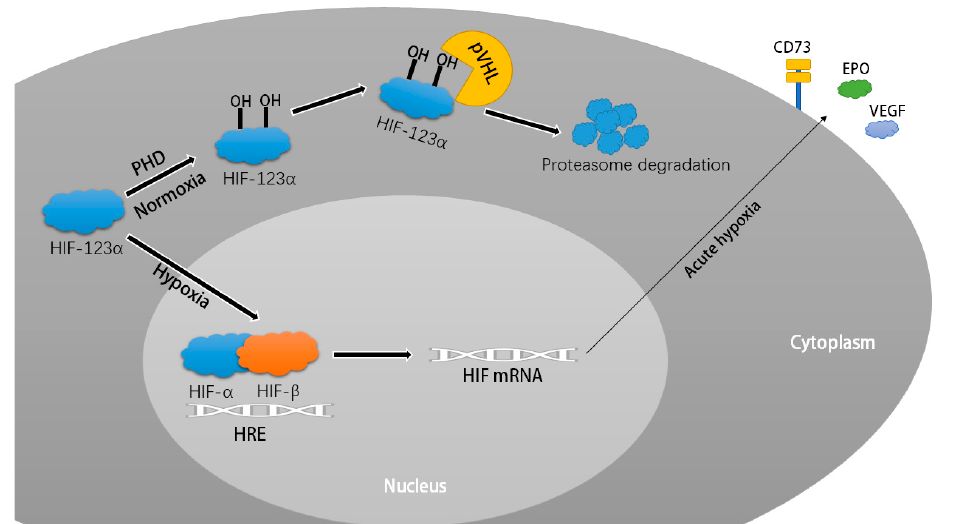
Figure 8. Degradation of HIF under normoxic conditions and the HIF signalling pathway under acute ischaemic conditions mediates protection through VEGF, EPO, and CD73.